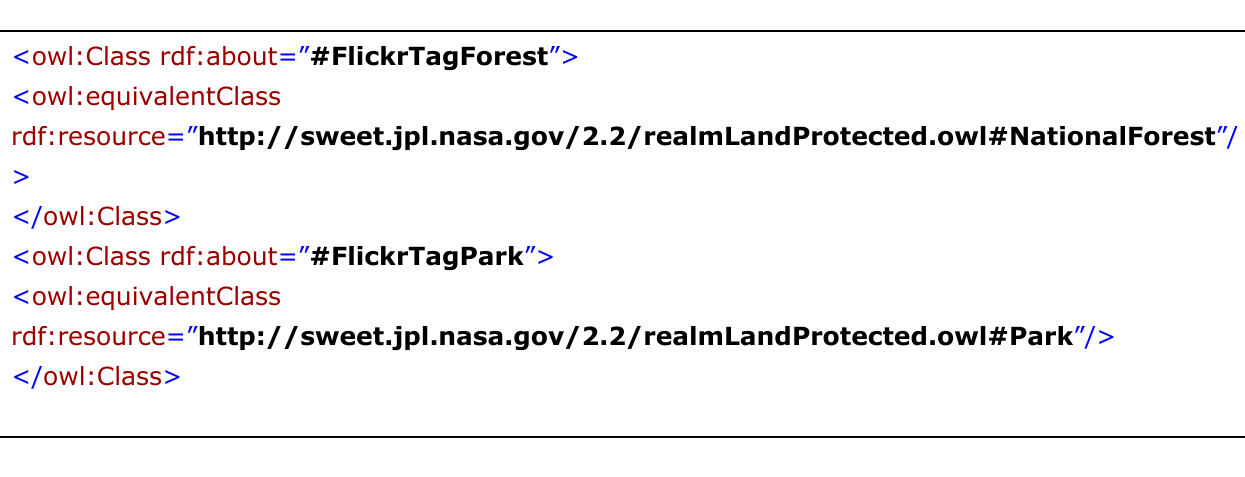
Figure 11. Example of registration mapping from OSM feature class to SWEET ontology